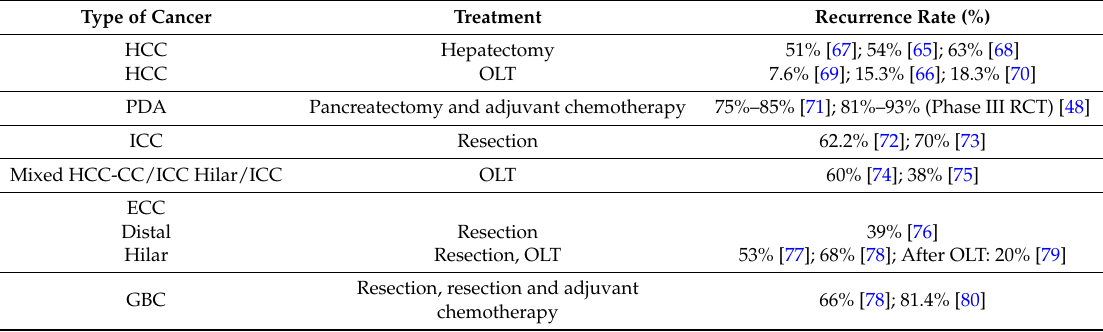
Table 2. Recurrence rates of hepatobiliary and pancreatic (HBP) cancers after surgical resection, in Phase III randomized controlled trials (RCTs) or retrospective